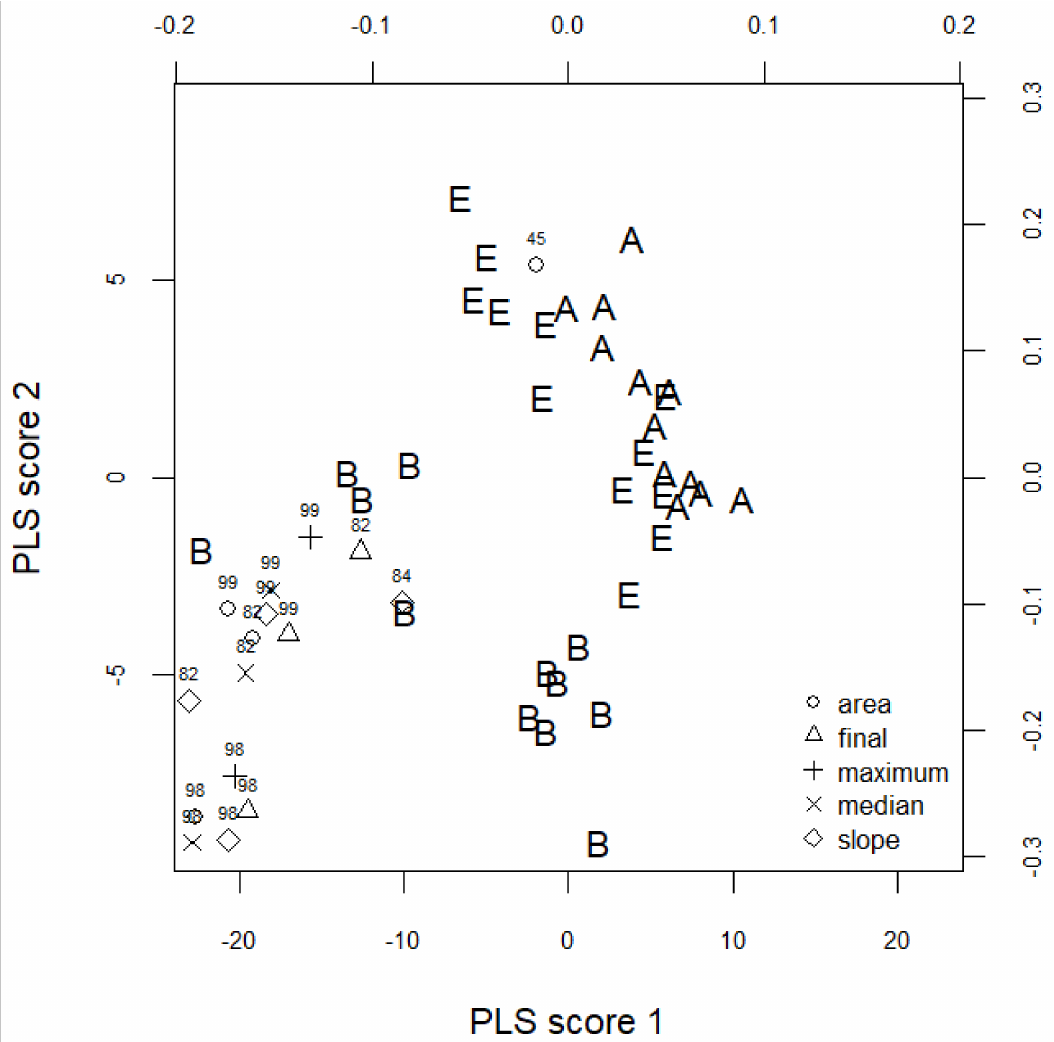
Figure 2. Graphical output of the Principal Least Square Discriminant Analysis of the espresso coffee nosespace analysis. In the score, plot letters depict nosespace sessions, and highly influential variables (VIP scores higher than 1.5) are represented by means of the corresponding rounded-up